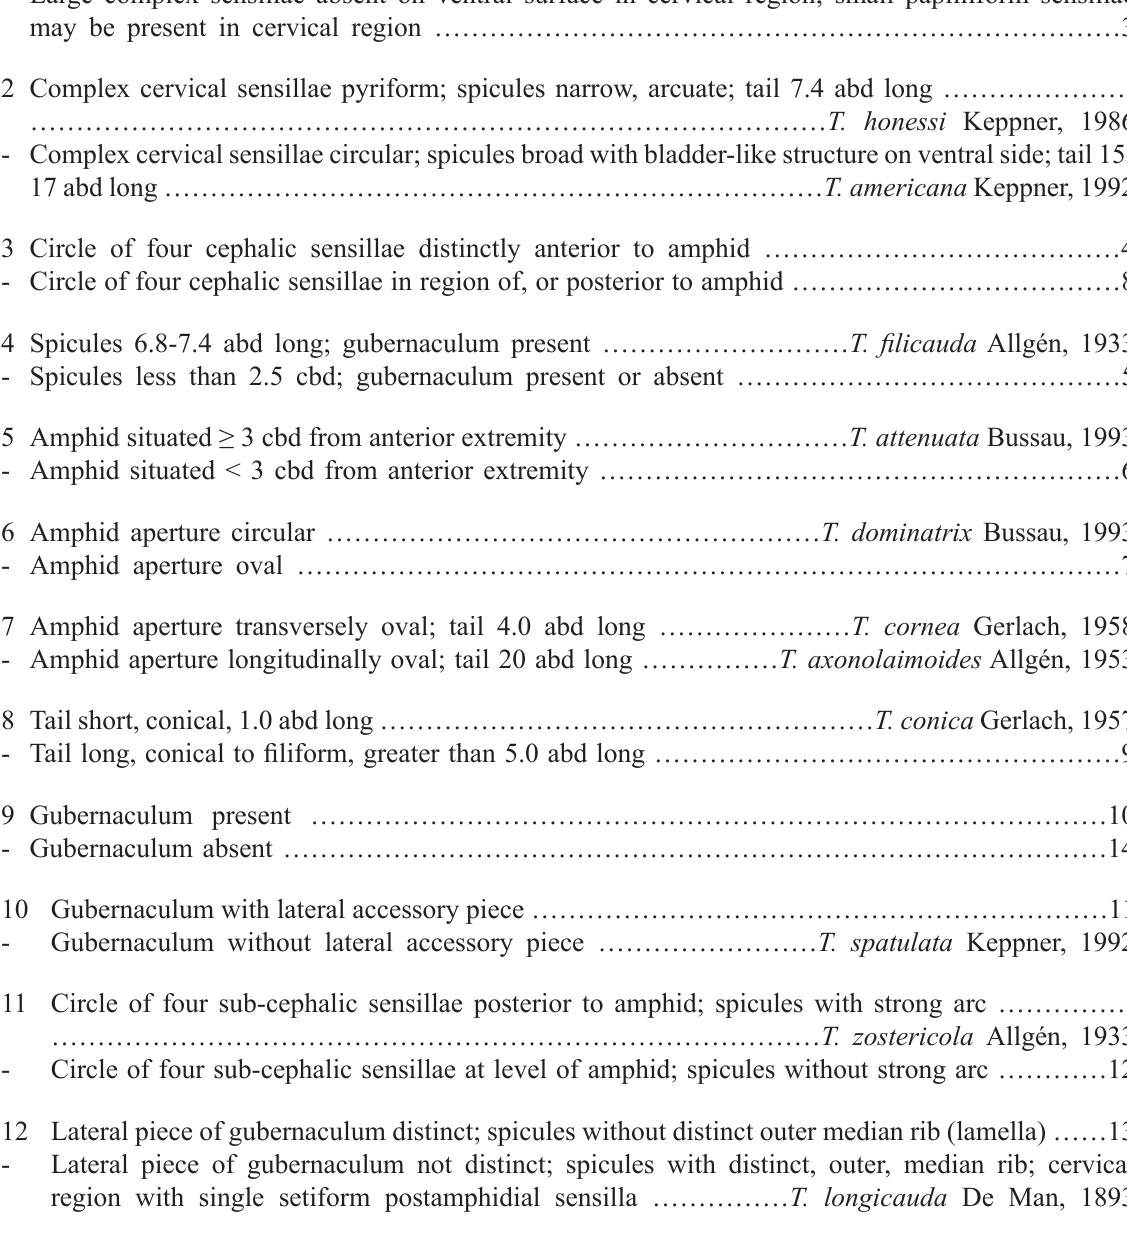
- circle of four cephalic sensillae in region of, or posterior to amphid ………………………………8